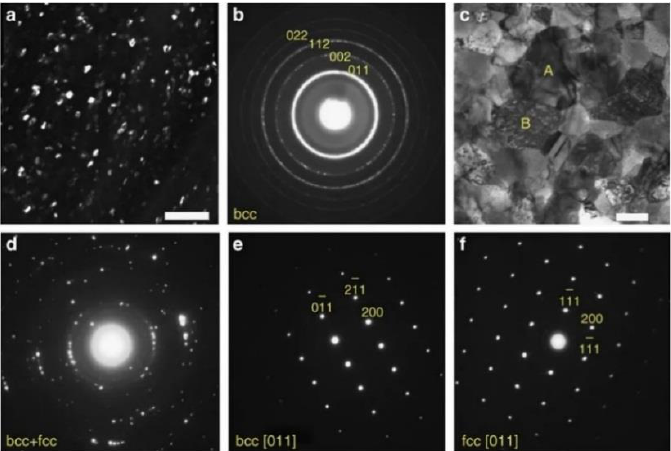
Figure 20. TEM images of Co0.73Fe0.27 of ( a ) (110) dark field image of as-deposited sample, the scale bar is 50 nm. ( b ) corresponding SAED pattern of the as-deposited, ( c ) bright field image of annealed sample, the scale bar is 200 nm. ( d ) SAED pattern of the same sample as ( c ) using ~1.5- µ m-diameter aperture showing the mixture structure of bcc and fcc phases, ( e ) [11] bcc di ff raction pattern from grain marked ‘A’ in ( c ), and ( f ) [11] fcc di ff raction pattern from grain marked ‘B’ in ( c ). Reprinted with permission from [119]. Copyright [2011], Springer